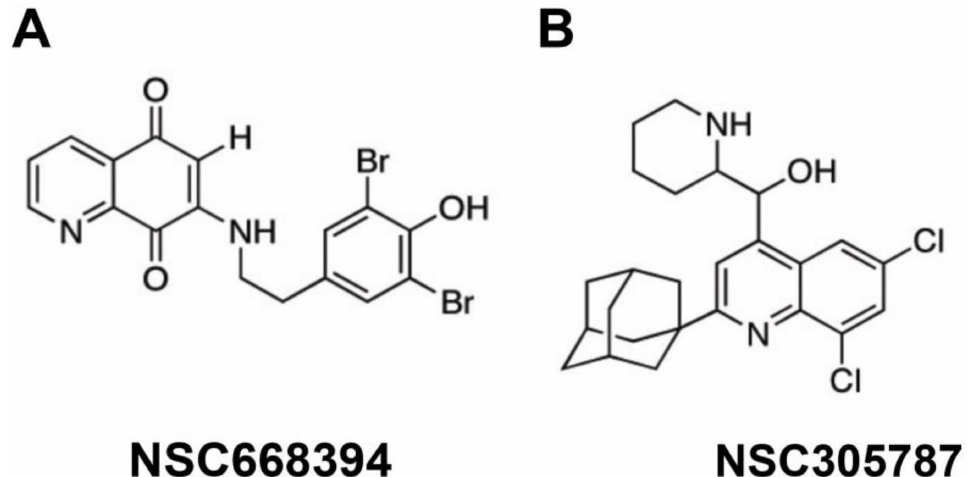
Figure 4. Chemical structures of putative pharmacological EZR inhibitors NSC668394 ( A ) and NSC305787 ( B